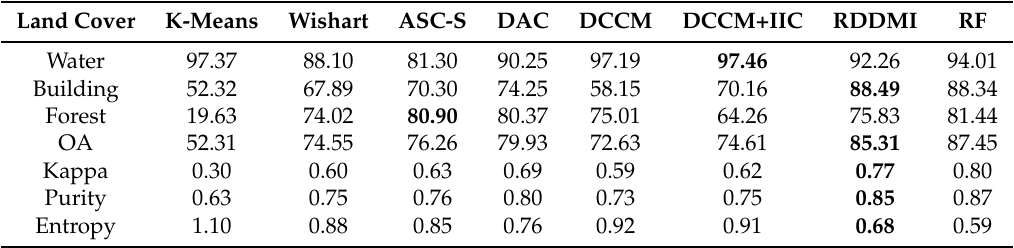
Table 5. Performance evaluation of RS-2 Wuhan classification results. The numbers in bold denote the best unsupervised classification